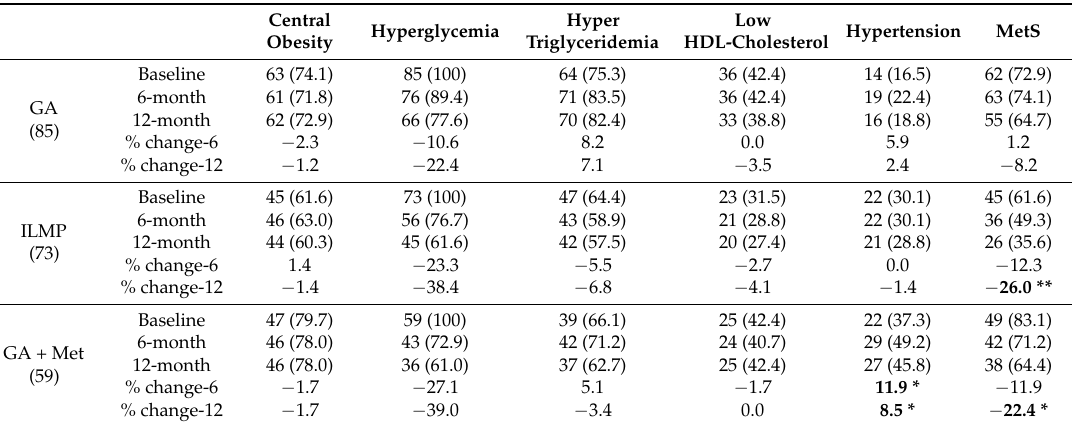
Table 2. Prevalence of MetS and its 5 components at baseline and follow-up.